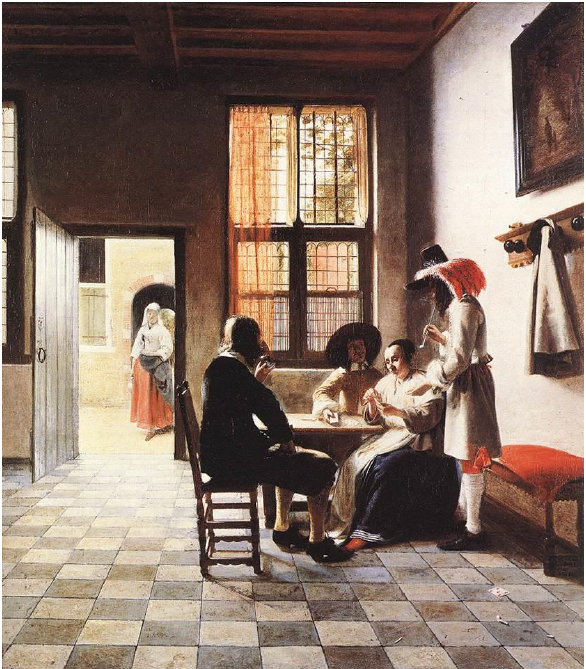
Figure 14. Pieter De Hooch, Card players in a Sunlit Room , 1658, Royal Collection, Windsor.